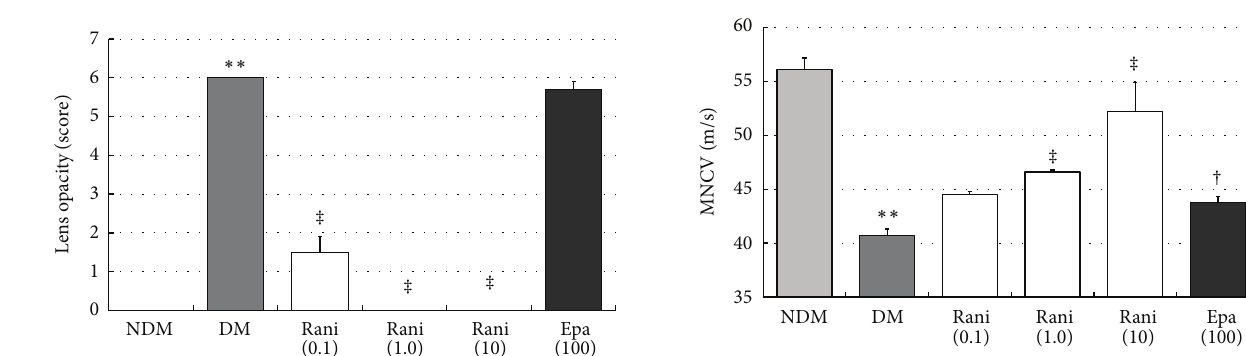
Figure 4: The total cataract scores at 15 weeks. The total cataract score of the untreated SDT rats at 15 weeks is significantly higher than that of the SD rats. ∗∗ 𝑃 < 0.01 , Wilcoxon rank sum test. The total cataract score of the SDT rats treated with ranirestat at 15 weeks is significantly lower than that of the untreated SDT rats. ‡ 𝑃 < 0.01 , Wilcoxon rank sum test. There is no significant difference in the total cataract score between the untreated SDT rats and the SDT rats treated with epalrestat. NDM: non-diabetes mellitus; DM: diabetes mellitus; rani: ranirestat; epa: epalrestat.